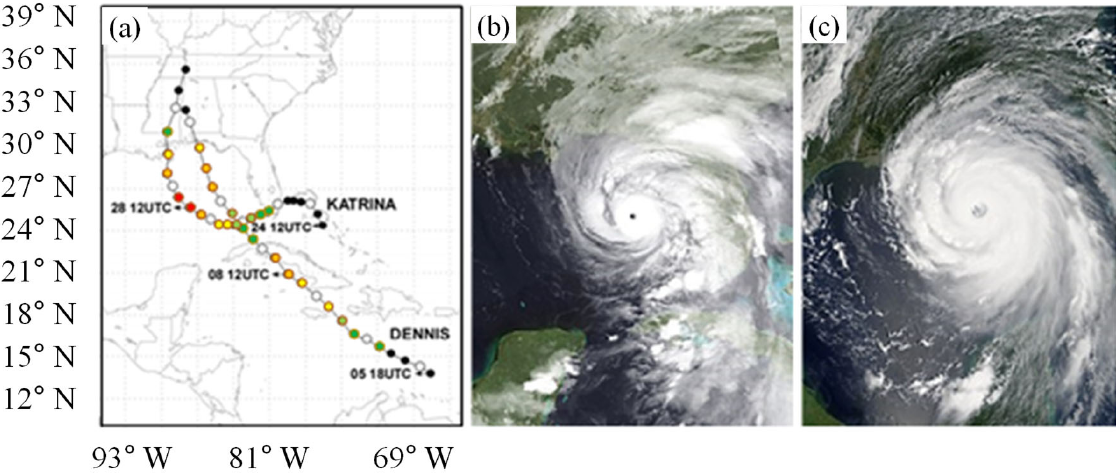
Figure 1. The track and intensity of Hurricanes Dennis and Katrina. The symbols shown in ( a ) were plotted every 6 h and the colors denote storm intensity categories on the Saffir–Simpson scale (category 1, green; category 2, light green; category 3, yellow; category 4, dark orange; category 5, red). ( b ) and ( c ) are images of Dennis and Katrina at their peak intensity on 10 July and 28 August 2005, respectively.